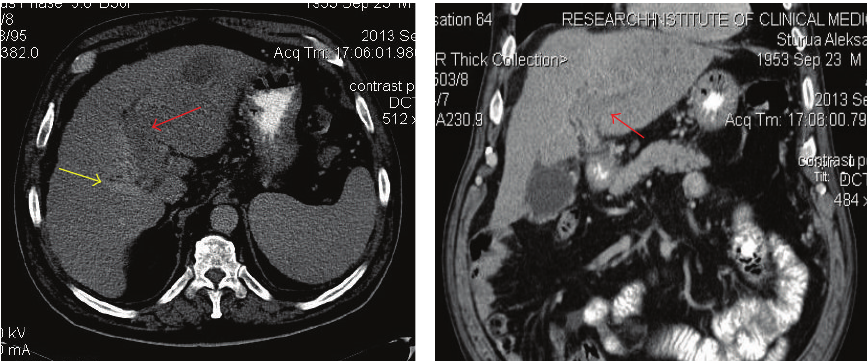
Figure 2: Preprocedure CT (portal phase): RPV patent branch (puncture “target” on VesOpen procedure), yellow arrow; completely obliterated LPV, red